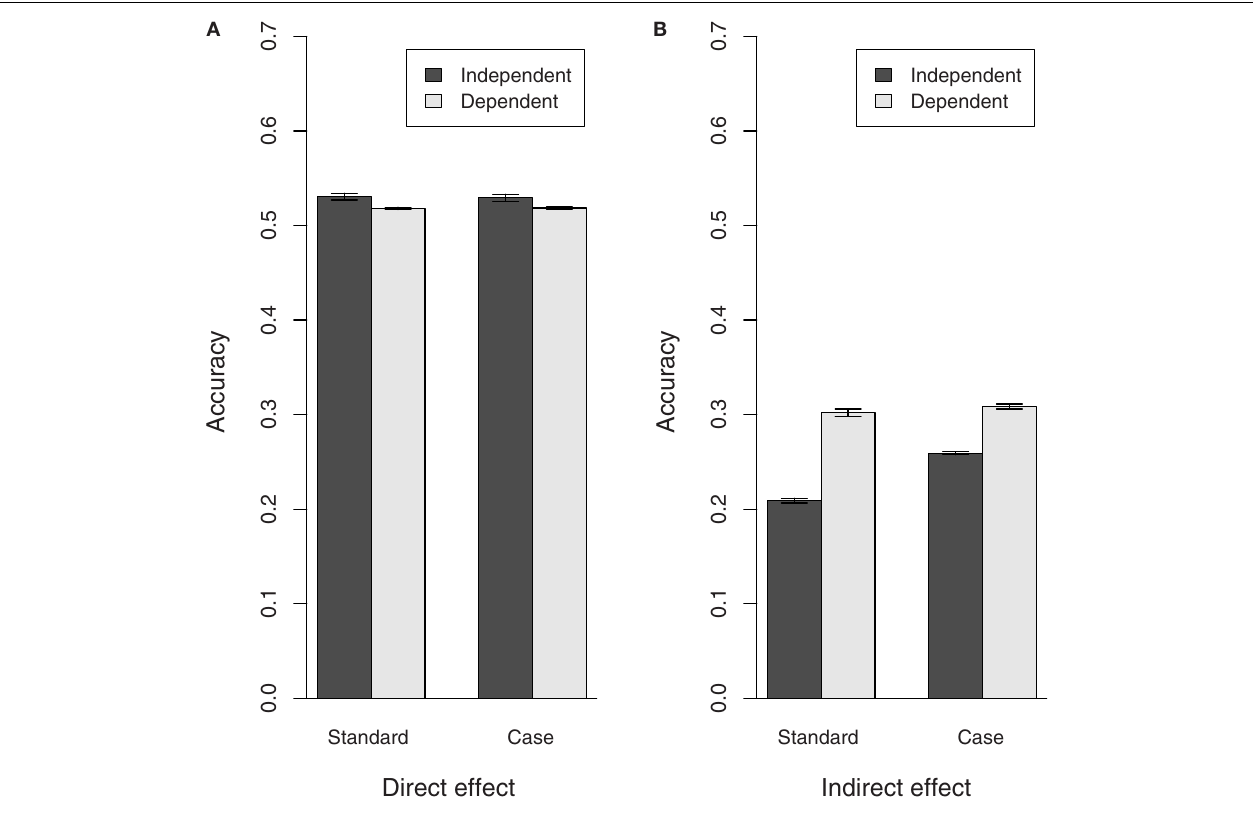
obtained for populations with different recovery rates.The correlation between susceptibility and infectivity is 0 in the independent population and 0.35 in the dependent population. (A) Direct effect, (B) indirect effect.